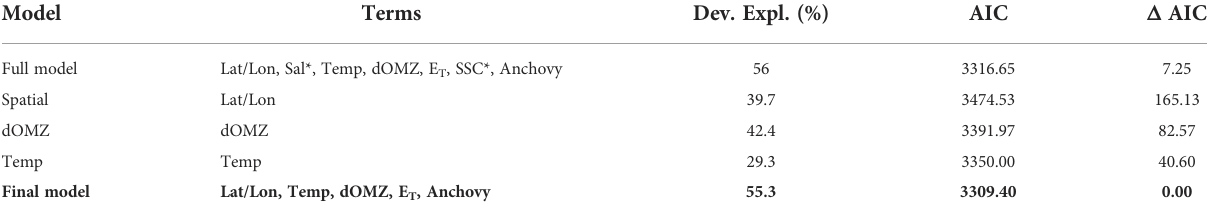
TABLE 3 HGAMs results for different tested models.